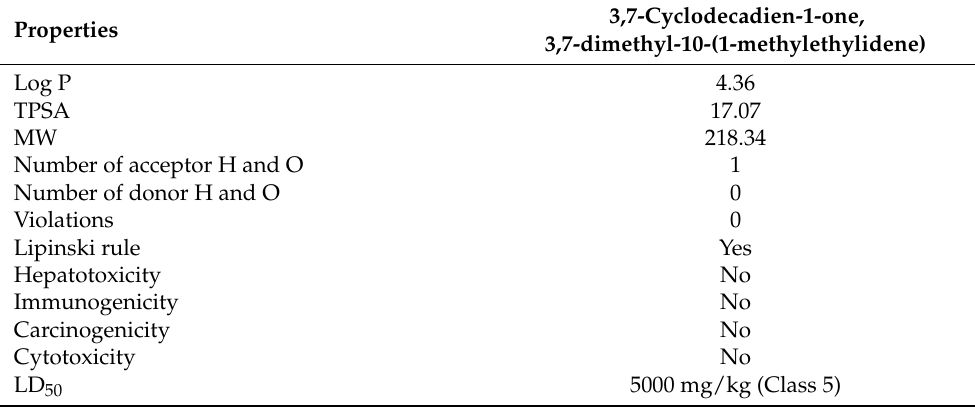
Table 7. Drug likeness prediction and toxicity prediction of the best docked ligand